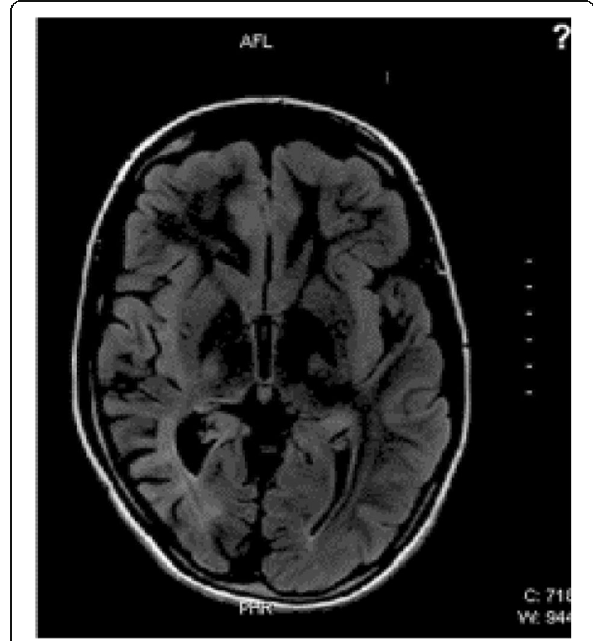
Fig. 4 MRI after sinus vein thrombosis and atrophy posterior cortex